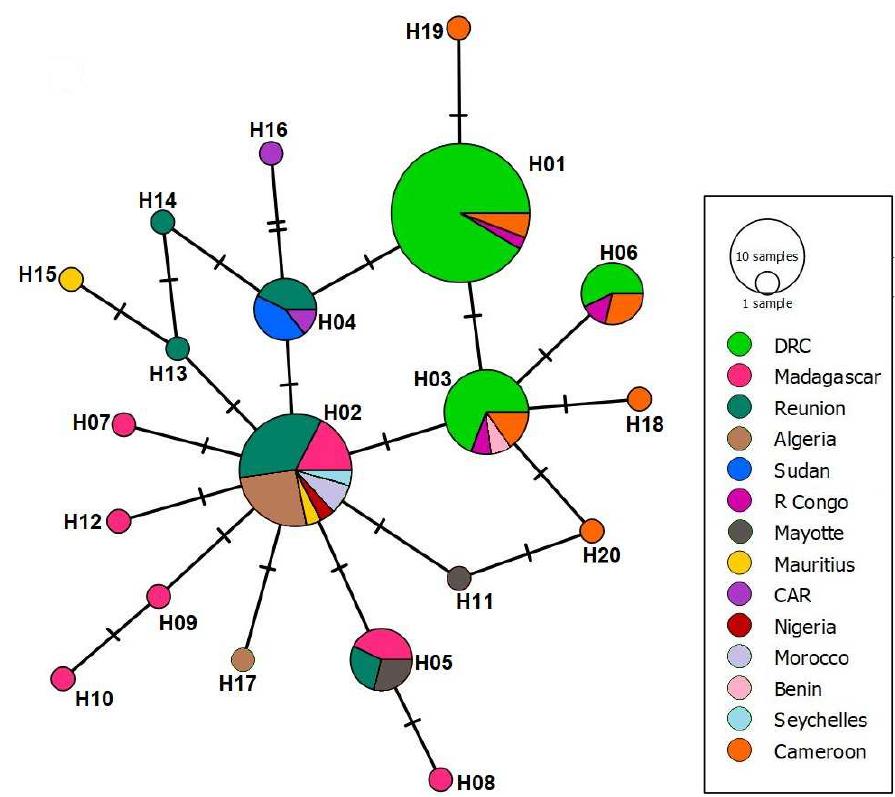
Figure 4. Parsimony haplotype network of the 103 African Ae. albopictus reference sequences and the 3 Sudanese Ae. albopictus sequences. Haplotypes of each region are presented using color coding. The number of each haplotype is written next to its representing node. Hatch marks in lines linking between the haplotypes are indicative of the numbers of nucleotide diversity. DRC: Democratic Republic of the Congo, R Congo: Republic of the Congo, and CAR: Central African Republic.